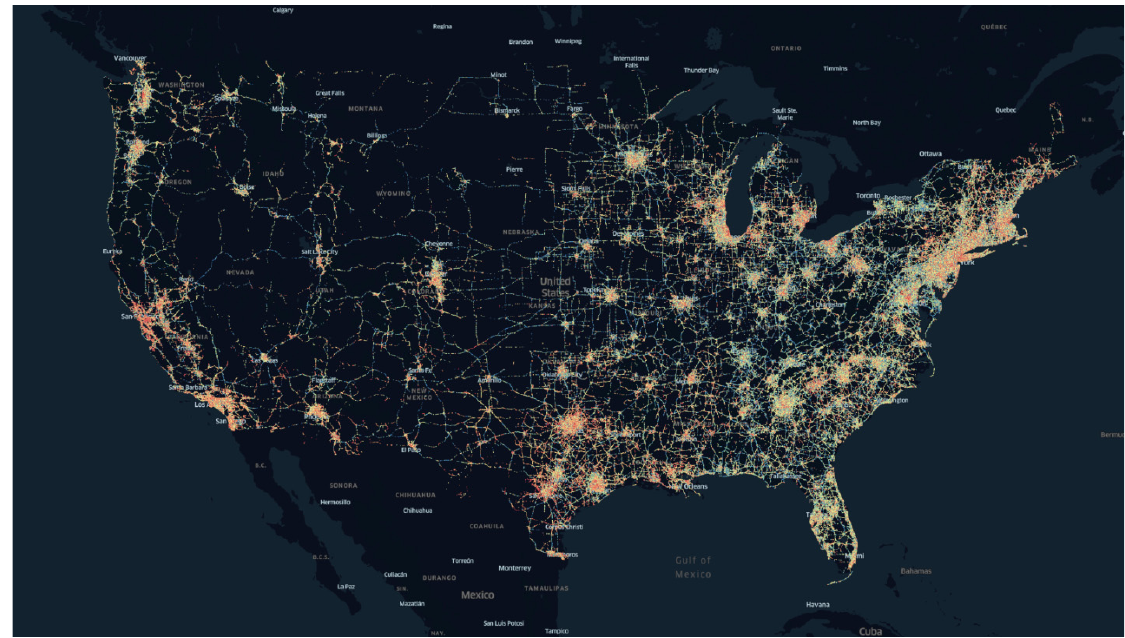
Figure 1. Current connected production vehicle coverage across the United States.